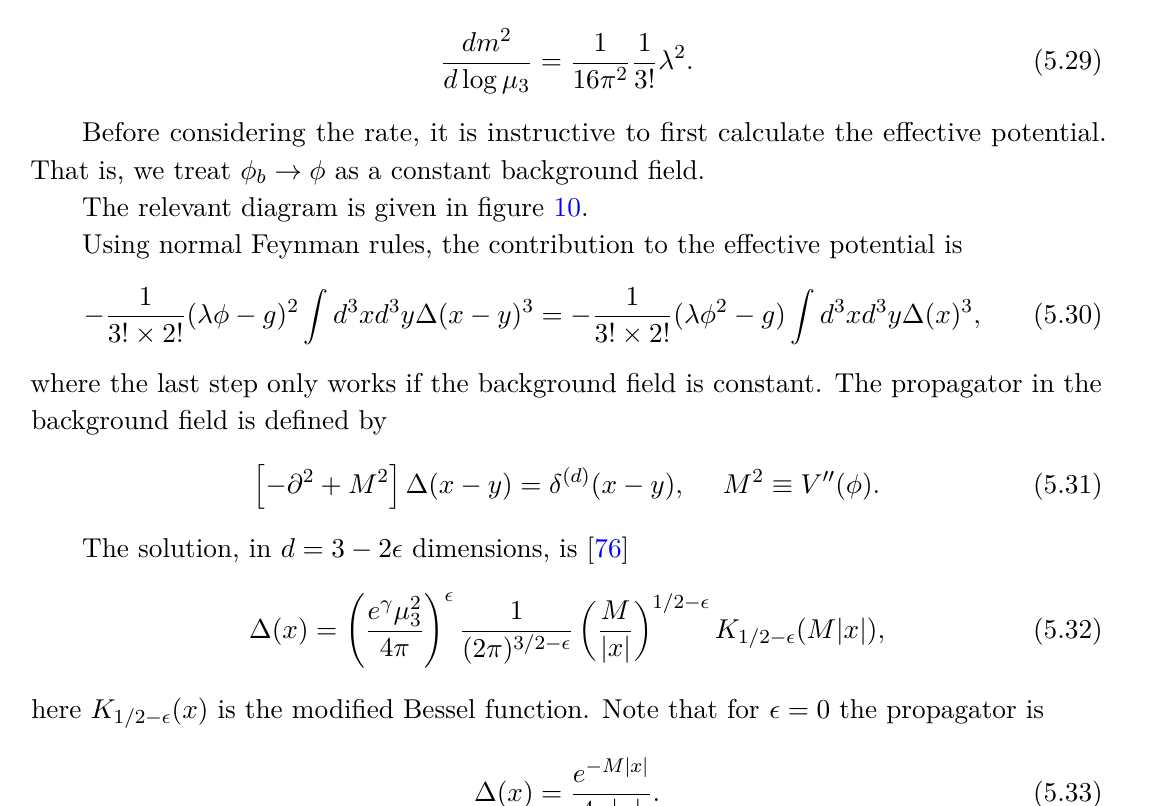
Figure 10 . Diagram contributing to the two-loop effective